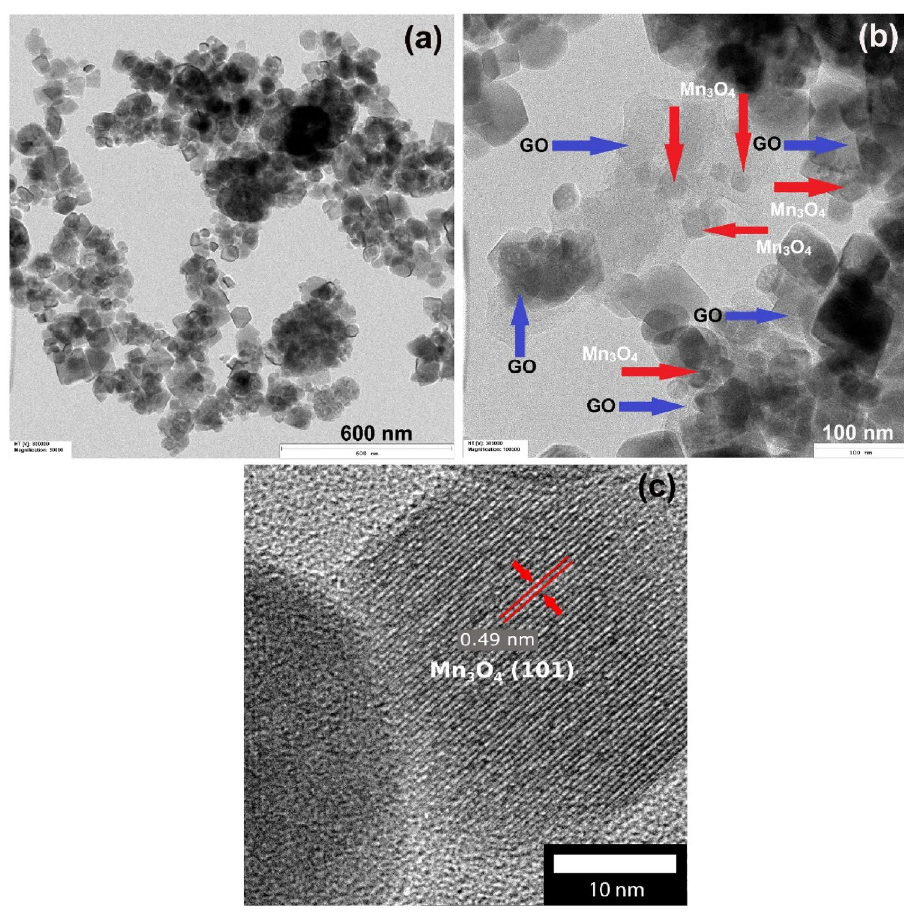
Fig. 4 TEM and HRTEM images of Mn O NP’s and 3 4 Mn O /10%GO NC’s : a TEM 3 4 image of Mn O NP’s; b TEM 3 4 image of a Mn O /10%GO NC’s 3 4 and c HRTEM of Mn O /10%GO 3 4 NC’s with d-spacing of Mn O 3 4 (101)